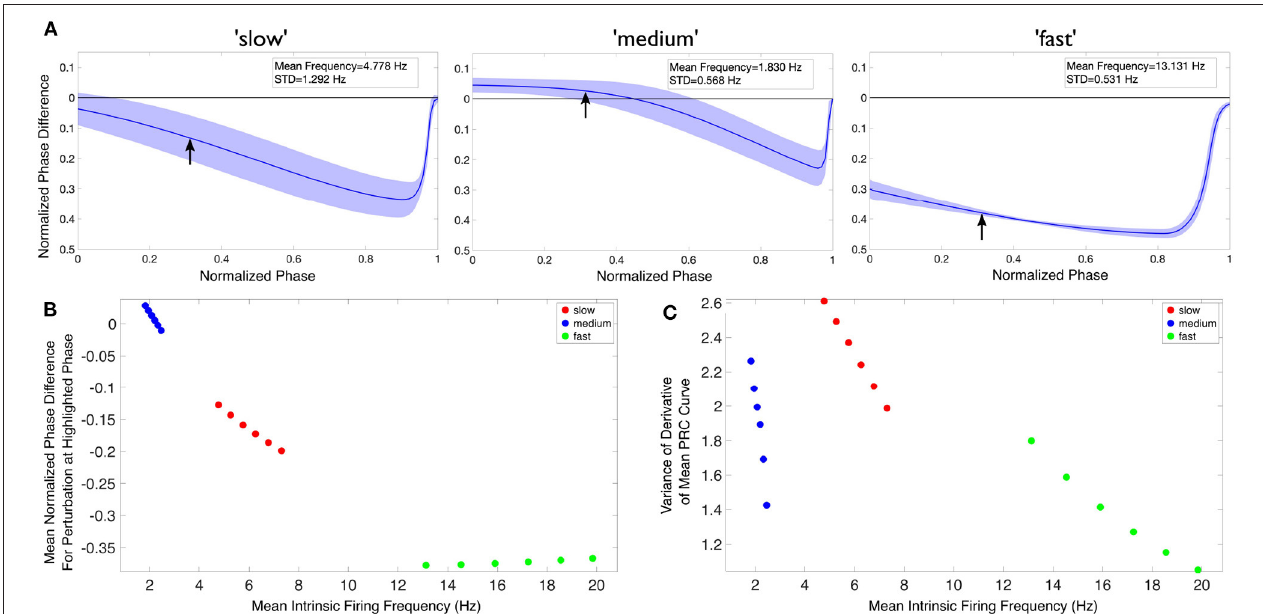
FIGURE 6 | Theta rhythm frequency is influenced by inhibitory drive as quantified via PRCs and firing frequencies of individual PYR cells. (A) Mean PRC (solid line) for the heterogeneous PYR cell population involved in “slow” (left), “medium” (middle), and “fast” (right) theta oscillations, calculated with an input current of 20 pA and with the shading representing ± the standard deviation. There are 25, 556, and 74 different PYR cell models in the 10,000 PYR cell populations of slow, medium, and fast cases, respectively. More details are provided in the Supplementary Material . The mean and standard deviation of the firing frequencies of the PYR cells at this input level are included in the inset of each panel. (B,C) After calculating both the mean PRC and mean intrinsic firing frequency for the PYR cell populations associated with our “slow” (red), “medium” (blue), and “fast” (green) theta oscillations for six input currents (20:2:30 pA), we extract a particular feature of the mean PRC (the mean phase shift caused by a perturbation delivered at a phase of 0.3 in (B) and the variance of the mean PRC’s derivative in (C) ) and plot it against the mean intrinsic firing frequency. In neither case is there a linear relationship between either axis and the theta rhythm frequency, indicating that it is a more complex combination that determines the population frequency. Note that, given the monotonic relationship between the input current and firing frequency in this range, the leftmost point for each color represents an input current of 20 pA, with each subsequent point moving rightwards representing the next input current